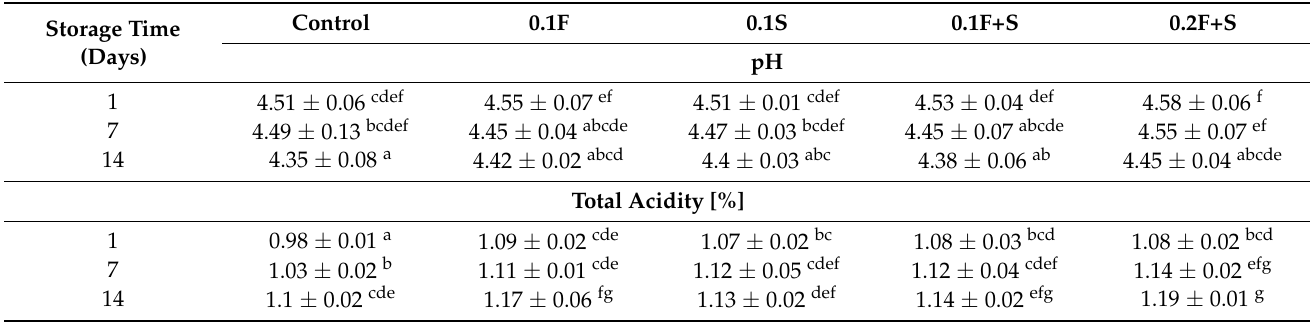
Table 3. Changes of pH and total acidity (%) in yoghurt samples during storage. Storage